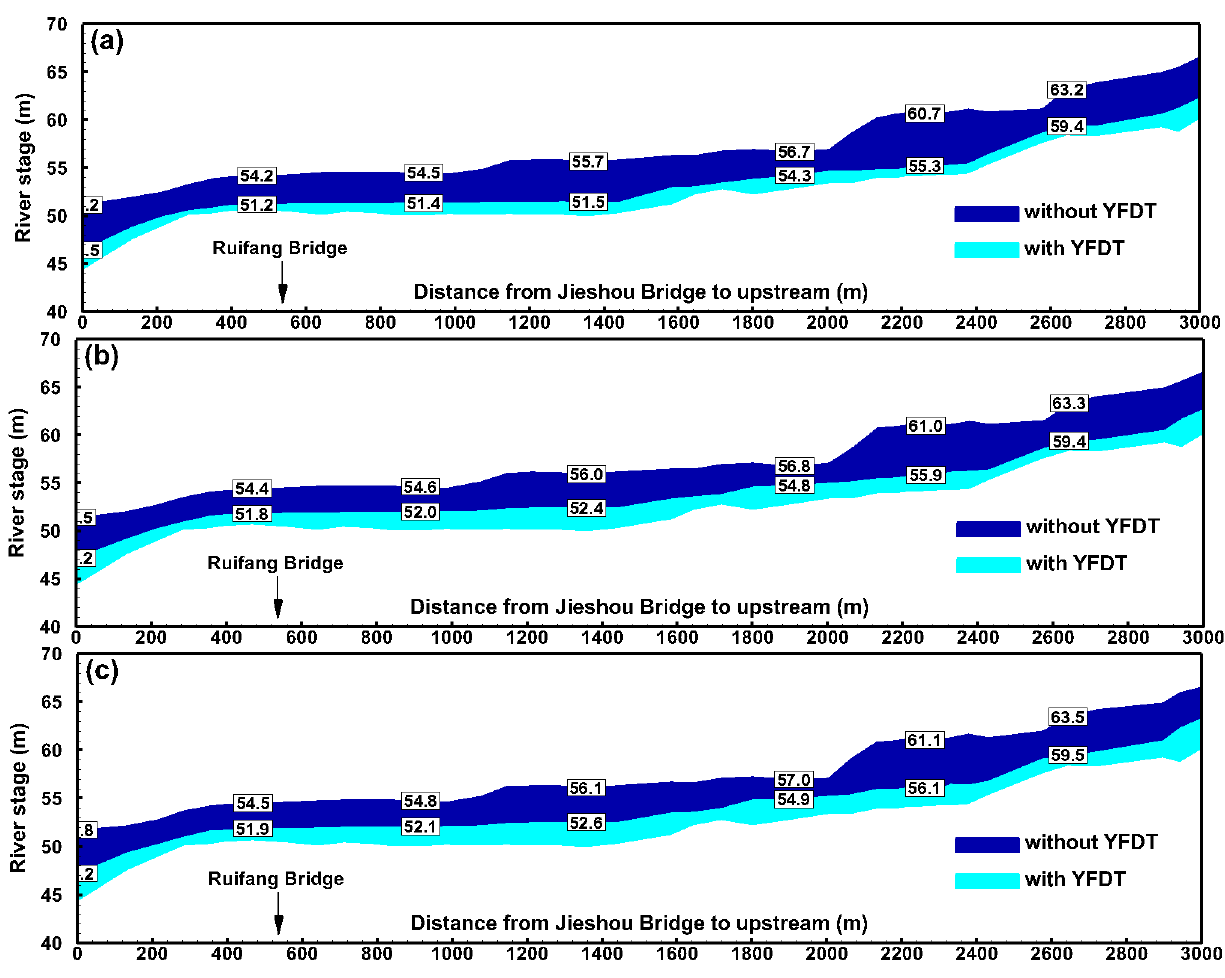
Figure 7. Comparison of the water levels along the Keelung River with (cyan color) and without (blue color) the Yuansantze flood diversion tunnel (YFDT) for the following return periods: ( a ) 50-year; ( b ) 100-year; and ( c )